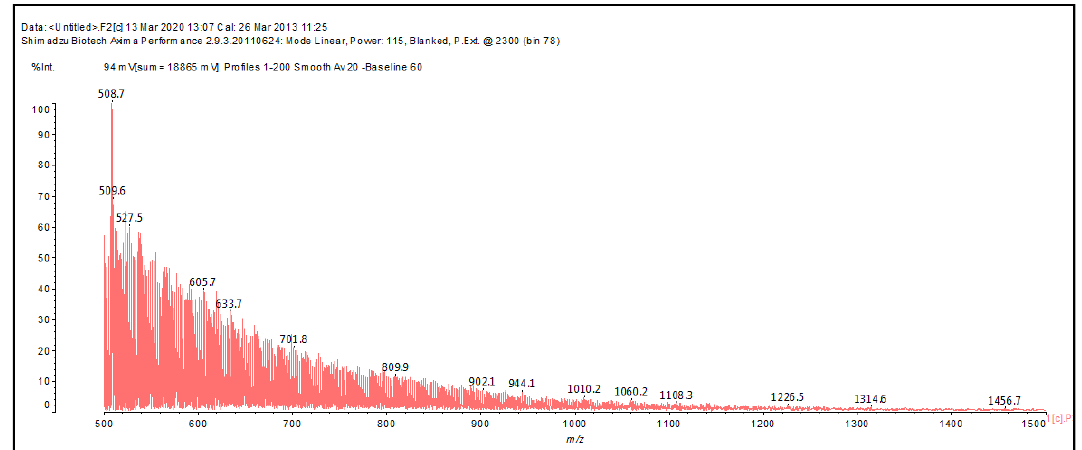
Figure 5. MALDI ToF spectrum of humins obtained at 180 °C from fructose, 700 – 900 Da range.